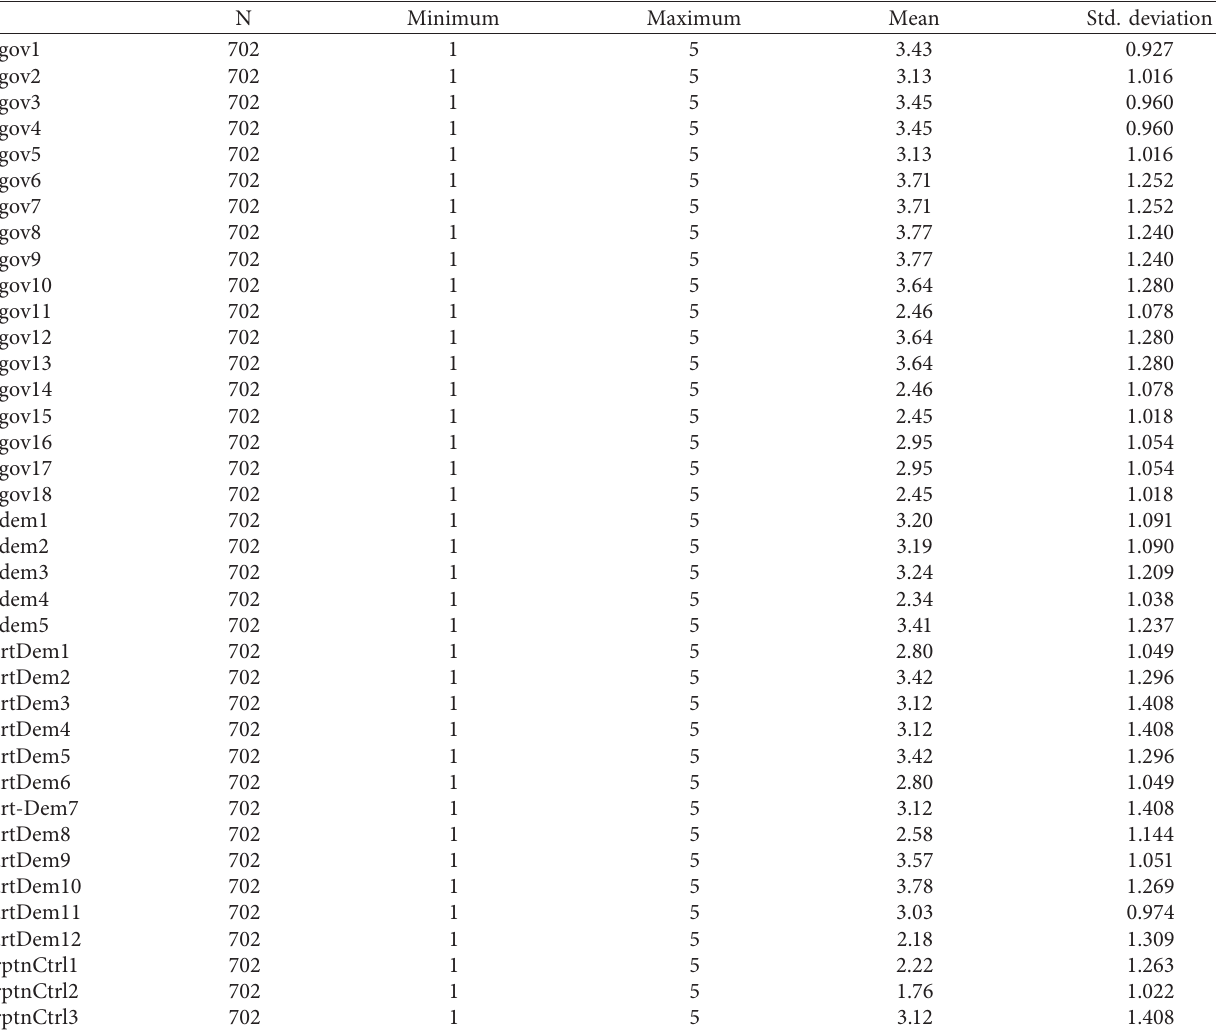
Table 3: Summarizes results of participants' answers based on measures of central tendency for each